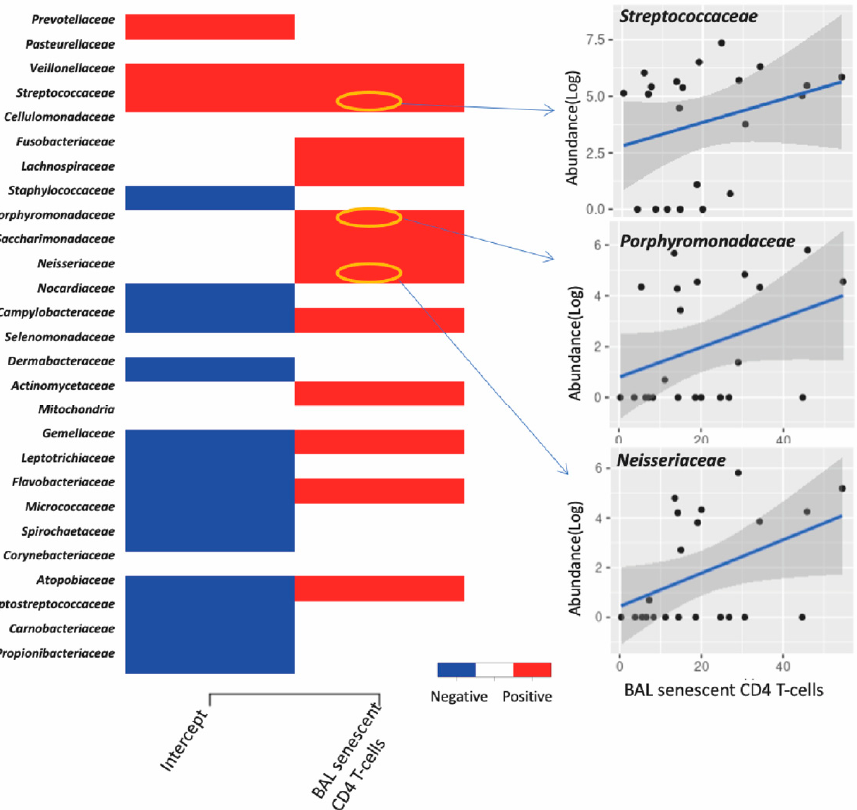
Figure 6. Effect coefficients of senescent CD4+ T-cells on the bacterial families. Three bacterial families were presented as examples whose abundance was influenced by senescent CD4+ T-cells (sample size = 22).